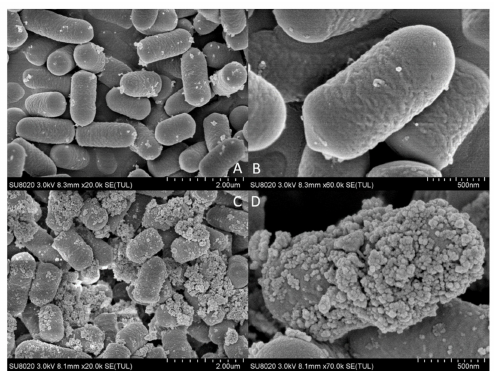
Figure 3. Lead-binding photomicrographs of L. plantarum YW11 by SEM. ( A , B ) Observation of YW11 in lead-free MRS medium; ( C , D ) observation of YW11 in MRS medium containing lead ions (100 mg / L).